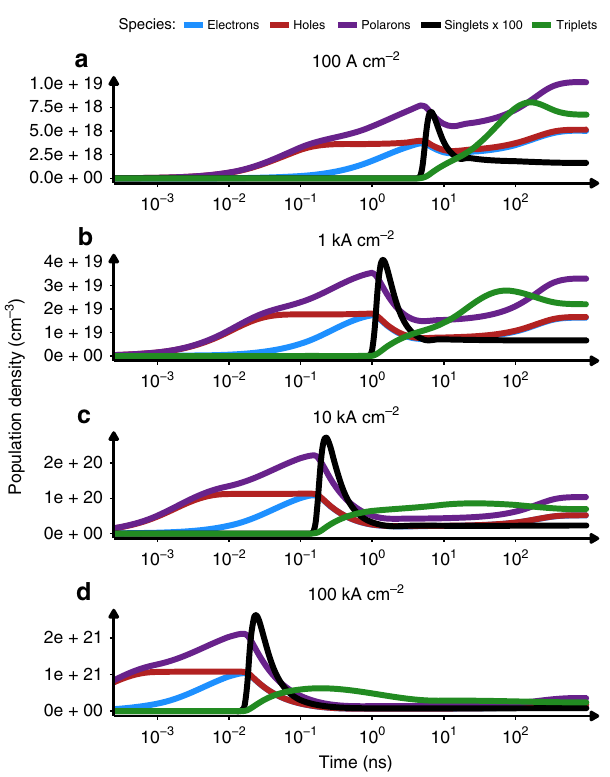
Fig. 3 Population transients under electrical excitation. Simulated temporal concentrations (averaged over recombination zone) of charge electrons, holes, polarons, singlets and triplets in devices under electrical pumping in the range of current densities, a 100 A cm − 2 . b 1000 A cm − 2 . c 10,000 A cm − 2 . d 100,000 A cm − 2 . is a signi fi cant difference from the optical pumping case, where shorter pulses are more effective, in general. In addition, the width recombination zone evolves as well (Supplementary Fig. 10). At the time the singlet population reaches maximum, recombination zone spans around 20% of the total organic layer width and the singlet spatial concentration is highly non-uniform, with peak values being order of magnitude higher than the averaged one (Supplementary Figs. 10 and 11). At longer times, it extends over the whole volume of organic layer, and the singlet population spreads out uniformly.